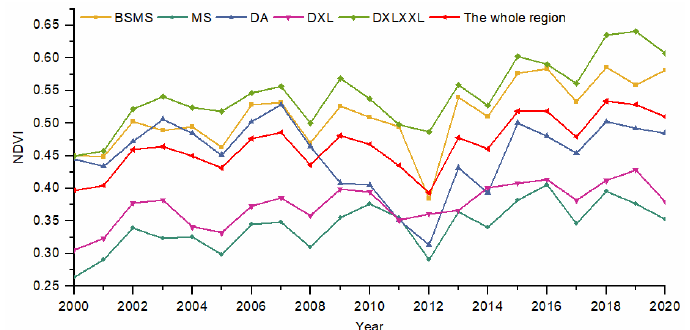
Figure 3. Average value of NDVI in different geomorphological zones from 2000 to 2020.